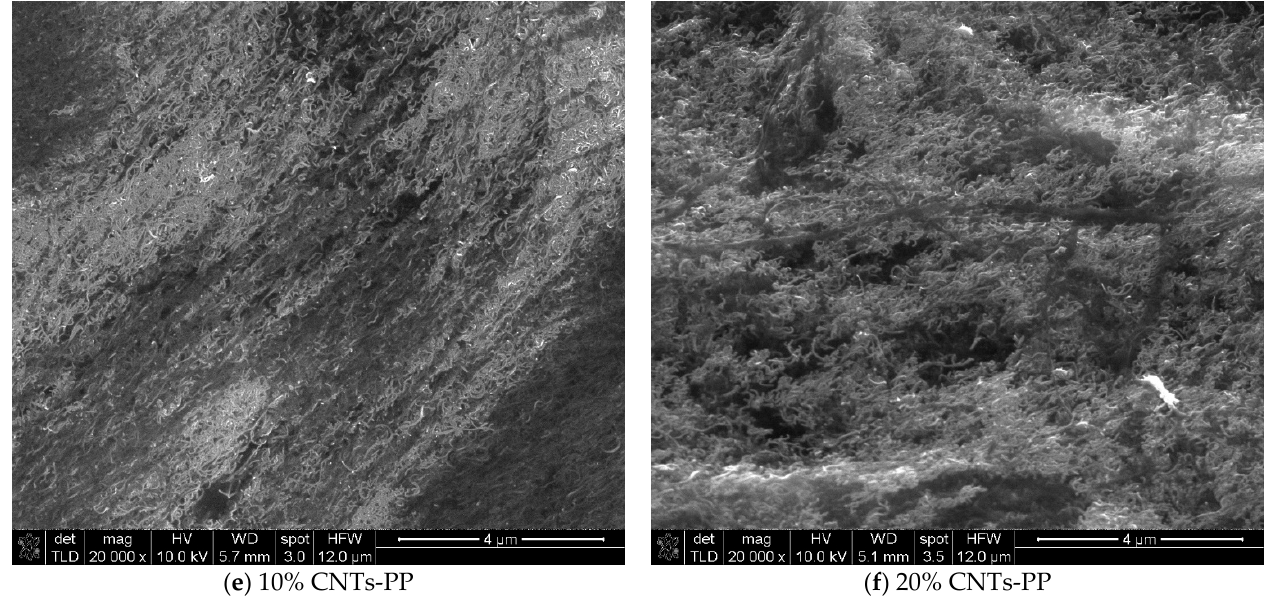
Figure 5. SEM characterization of ( a ) 10% GNPS ‐ PP, ( b ) 20% GNPS ‐ PP, ( c ) 10% GNPV ‐ PP, ( d ) 20% GNPV ‐ PP, ( e ) 10% CNTs ‐ PP, and ( f ) 20% CNTs ‐ PP composite materials at ×20,000 magnification.